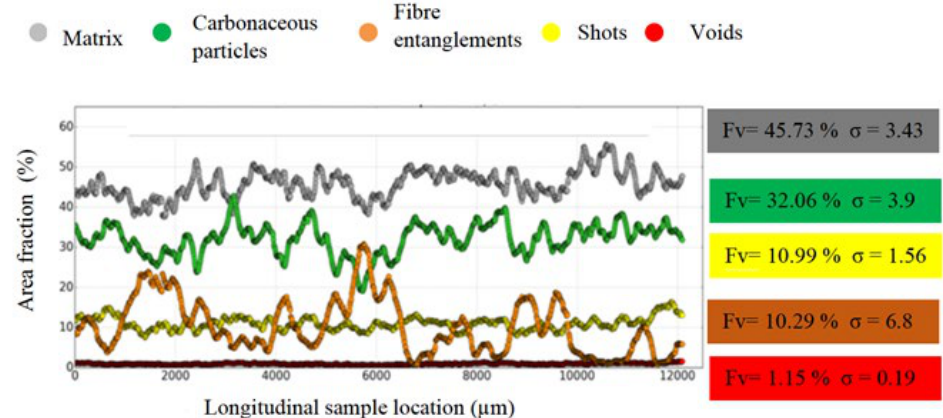
Figure 8. Spatial constituents’ distributions according to the longitudinal location (Z-axis) along the sample in M2, with volume fraction (Fv) and standard deviation (σ) of each constituent.